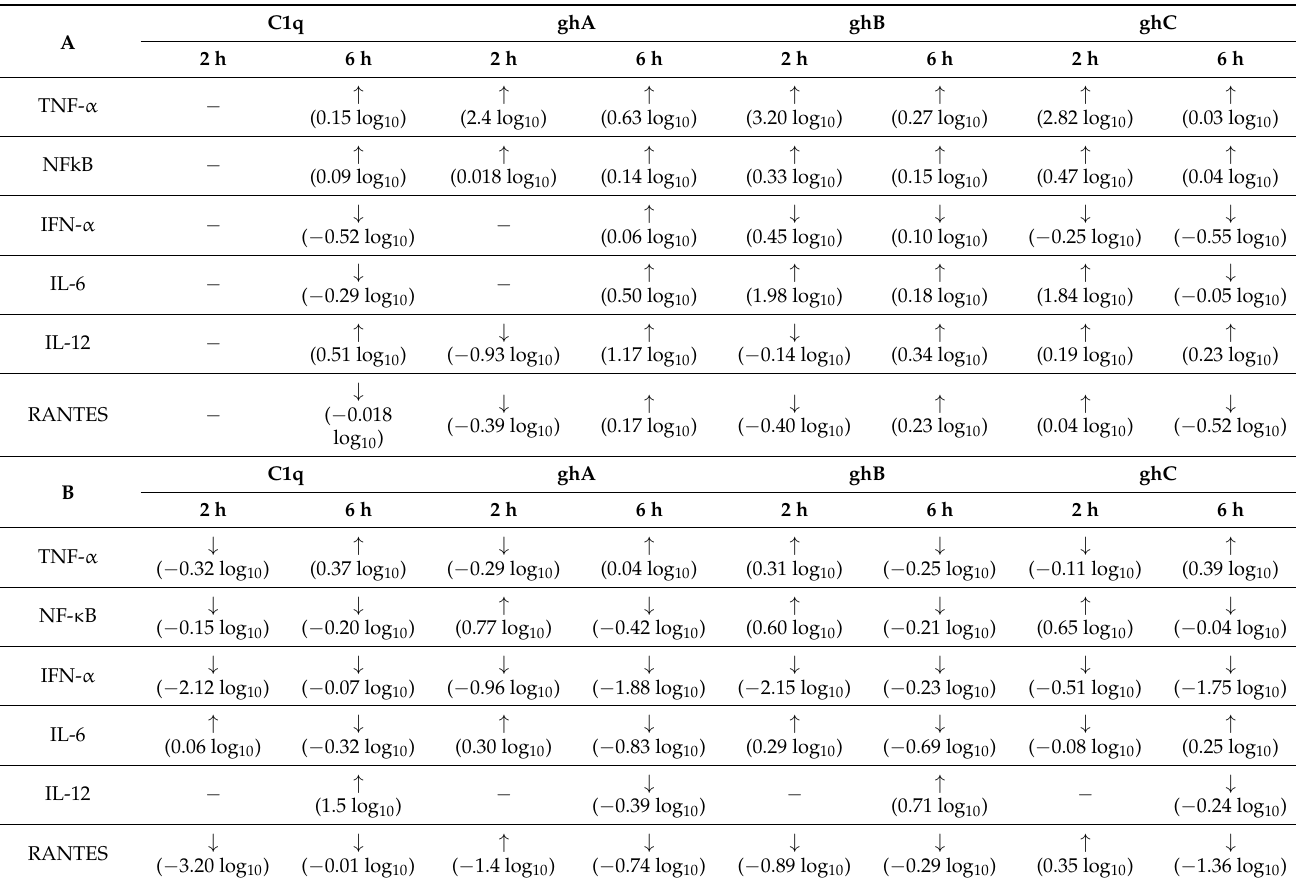
Table 1. Cytokine response in A549 cells challenged with C1q-, ghA-, ghB-, or ghC-treated H1N1 ( A ) or H3N2 ( B ) virus (“ ↑ ” = upregulation; “ ↓ ” = downregulation; “ − ” = no